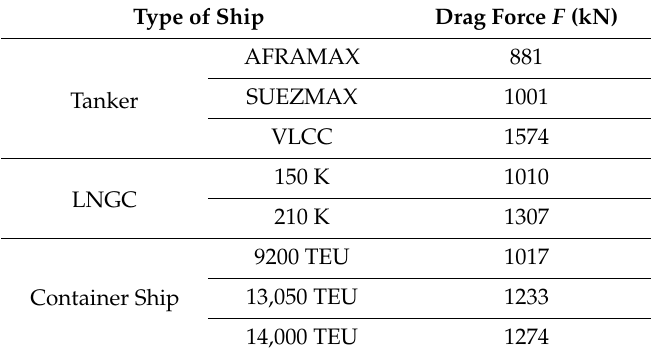
Table 3. Drag force ( F ) exerted on each type of ship.